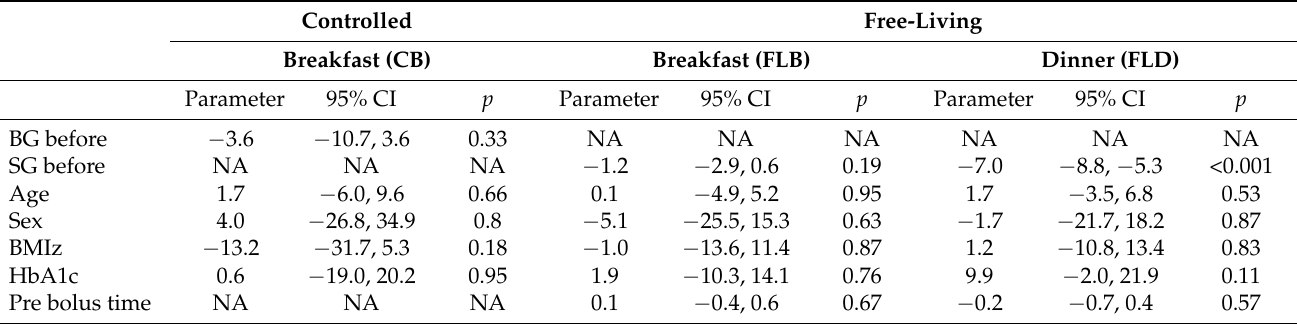
Table 4. Linear mixed model displaying the parameter, 95% confidence interval (Cl), and p value of multiple covariates on the time to peak glycaemic response during each study